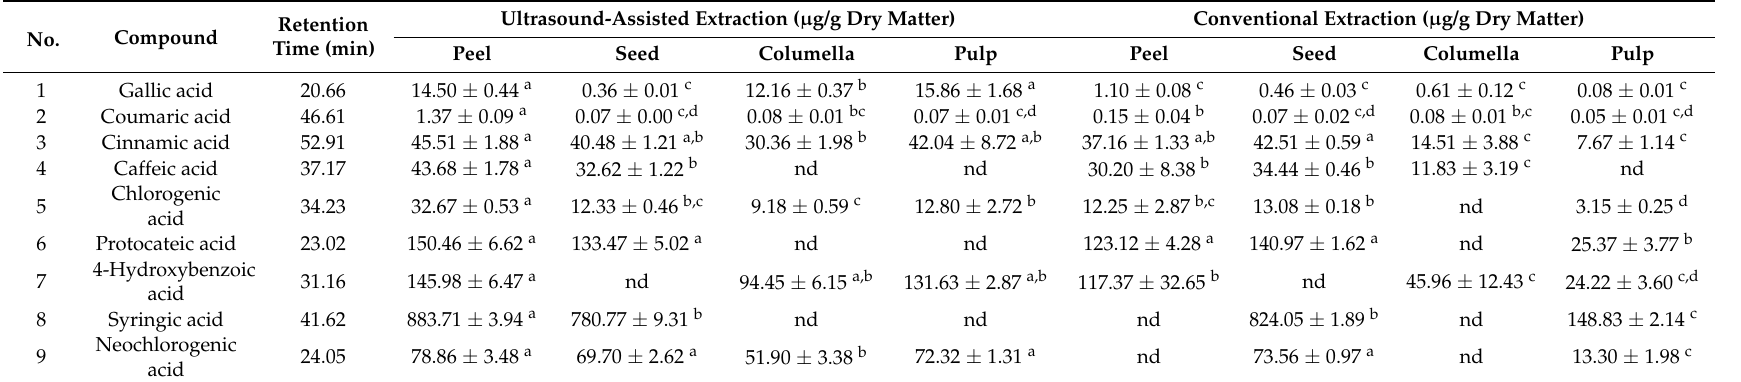
Table 6. Profile of soluble polyphenols from Annona muricata peel, seed, columella, and pulp using the optimal conditions of ultrasound-assisted extraction and conventional extraction (extraction for 2 h under stirring, see Section